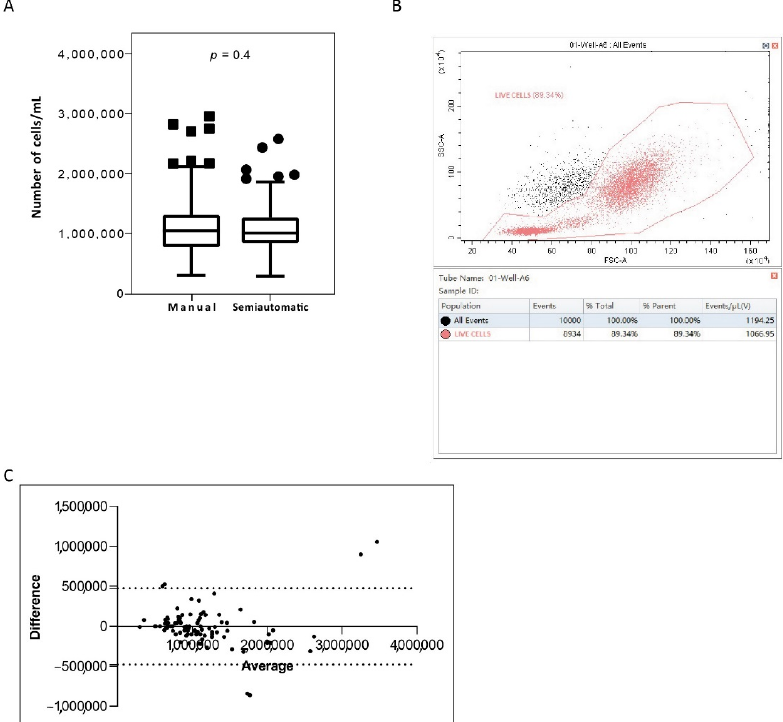
Figure 3. White blood cell isolation efficiency on blood samples processed with the manual and semiautomatic protocols. ( A ) White blood cells were isolated from 14 mL matched peripheral blood samples of CML patients (N = 100) with a manual method or a newly semiautomatic method based on the Biomek i-5 Automated Workstations integrated with the CytoFLEX Flow Cytometer. Cell counts, expressed as number of cells/mL, were analysed to determine cell recovery efficiency. The number of cells was determined for each method and depicted as boxplots delimited by the 25th (lower) and 75th (upper) percentile. Horizontal lines above and below each boxplot indicate the 5th and 95th percentile, respectively. Thick lines in each boxplot represent number cell median/mL in each method. The Wilcoxon signed-rank test was used to test the difference between the platforms. The symbols ▪ and ● indicate the manual and the semiautomatic method, respectively. p value below 0.5 was considered statistical significant. ( B ) The figure shows the acquisition screen on the CytoFLEX Platform. The CytExpert software includes gates to visualize the distribution of total white cells isolated from blood of CML patient. Cell lives are indicated by the gate and depicted in rose. SSC-A: Side scatter-area; FSC-A: forward scatter-area. ( C ) The graph is plotted on the XY axis where X represents the difference of the two measurements, and the Y -axis shows the mean of the two measurements. Horizontal lines are drawn at the mean difference between the two methods and the upper and lower limits of agreement. The 95% confidence intervals are shown for the mean and the upper and lower limits of